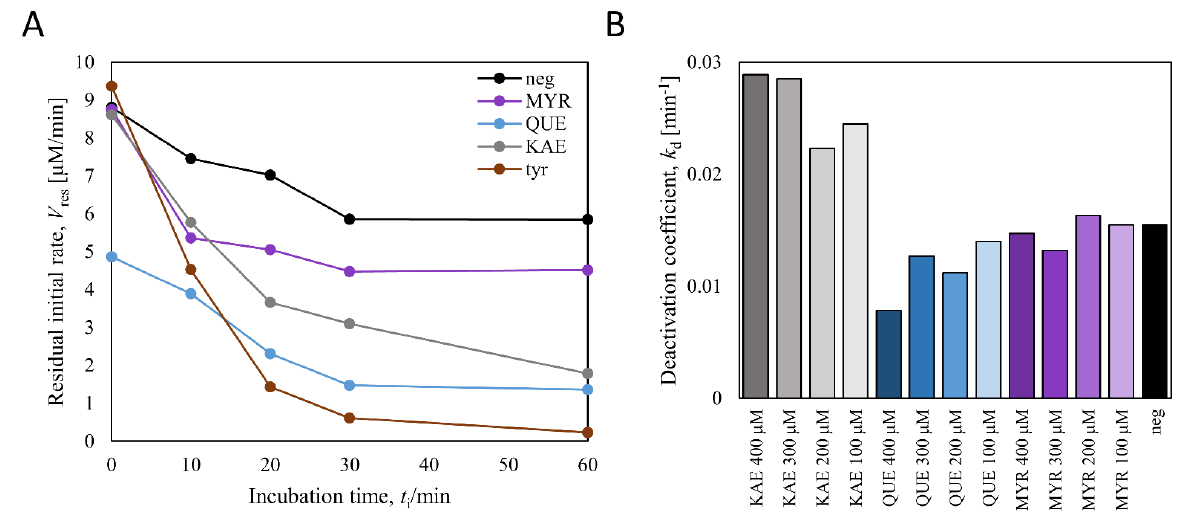
Figure 8. Deactivation kinetics of Bm Ty with 0.5 mM of kaempferol, quercetin, and myricetin. ( A ) and the deactivation coefficients with respect to 0.1~0.4 mM of putative deactivators ( B ). Each sample was represented with abbreviations, those are: neg: negative control (no putative deactivator), MYR: myricetin, QUE: quercetin, KAE: kaempferol, tyr: L-tyrosine.